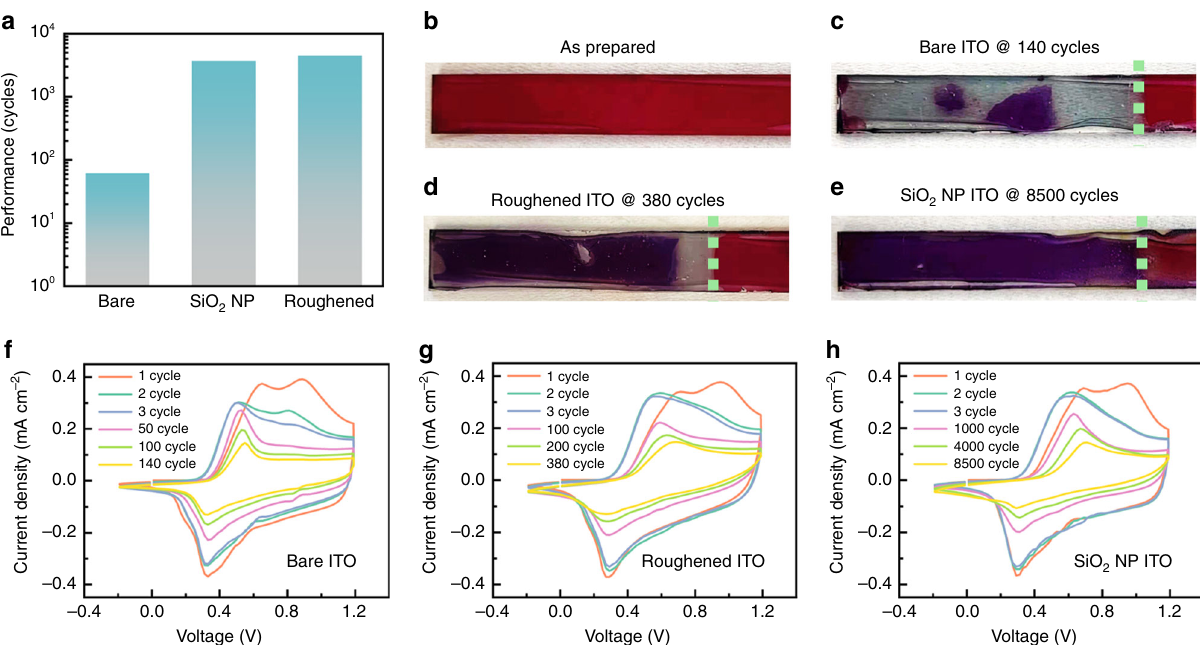
Fig. 6 Interfacial modi fi cation of electrochromic electrode. a The surface treatment and improvement of interfacial contact considerably enhance the cyclic performance of OECDs. ( b )-( e ) show the images of the as-prepared PProDOT fi lm on bare ITO, PProDOT on bare ITO after 140 cycles, PProDOT on roughened ITO after 380 cycles, and PProDOT on SiO 2 NP treated ITO after 8500 cycles, respectively. The cyan dot lines indicate the electrolyte front line. ( f ) – ( h ) show the cyclic voltammetry responses of PProDOT fi lm on bare ITO, roughened ITO, and SiO 2 NP-treated ITO,